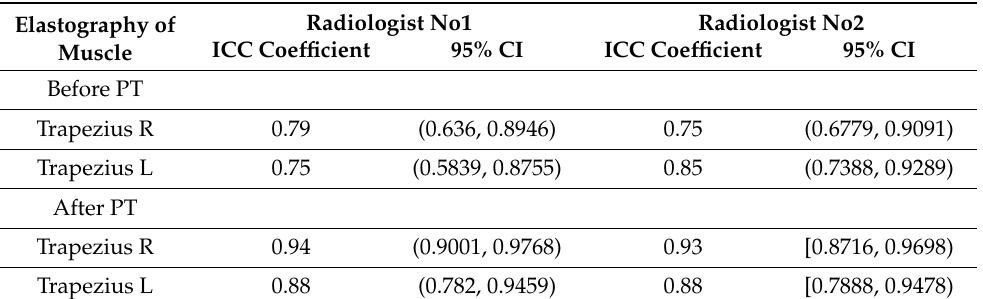
Table 2. Intra-observer reliability of elastography measurements in trapezius muscles before and after physical therapy.